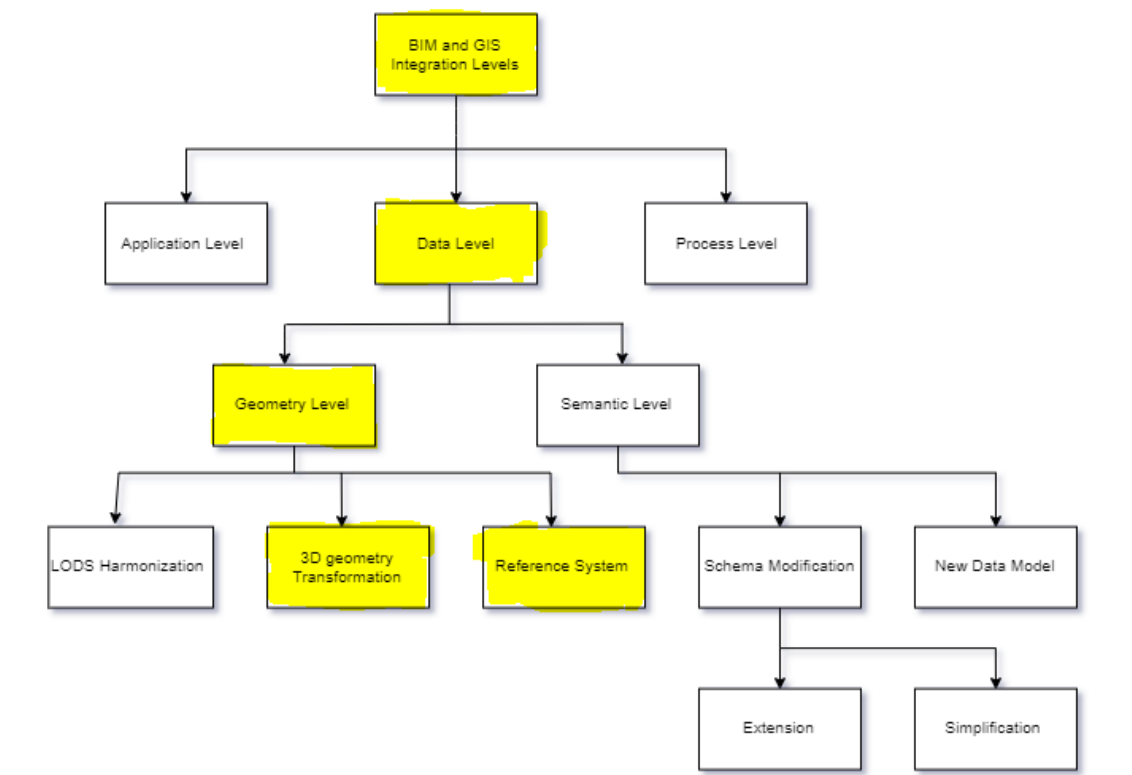
Figure 1. Levels of BIM and GIS